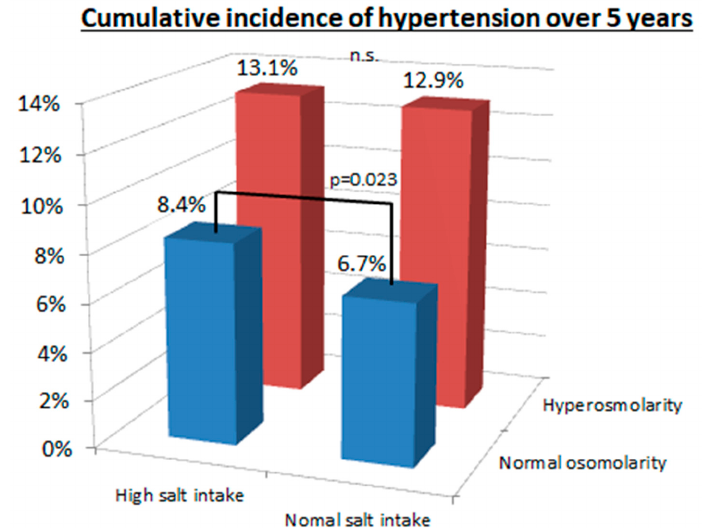
Figure 3. Cumulative incidence of hypertension between hyperosmolarity and normal osmolarity and between high and normal salt intake. There was a significant di ff erence in cumulative incidence of hypertension between high salt intake ( > 12 g / day) and normal salt intake ( ≤ 12 g / day) in the normal osmolarity group (8.4% versus 6.7%, p = 0.023), but not in the hyperosmolarity group (13.1% versus 12.9%, p = 0.84). In contrast, the hyperosmolarity group ( > 293.3 mOsm / L) had significantly higher cumulative incidence of hypertension compared with the normal osmolarity group ( ≤ 293.3 mOsm / L) both in the high salt intake group (13.1% versus 8.4%, p < 0.001) and the normal salt intake group (12.9% versus 6.7%, p < 0.001). Table 3. Risk factors for hypertension over five years after multiple adjustments using serum osmolarity ( A ) and each element of serum osmolarity, namely, blood urea nitrogen, serum sodium, and fasting blood glucose ( B